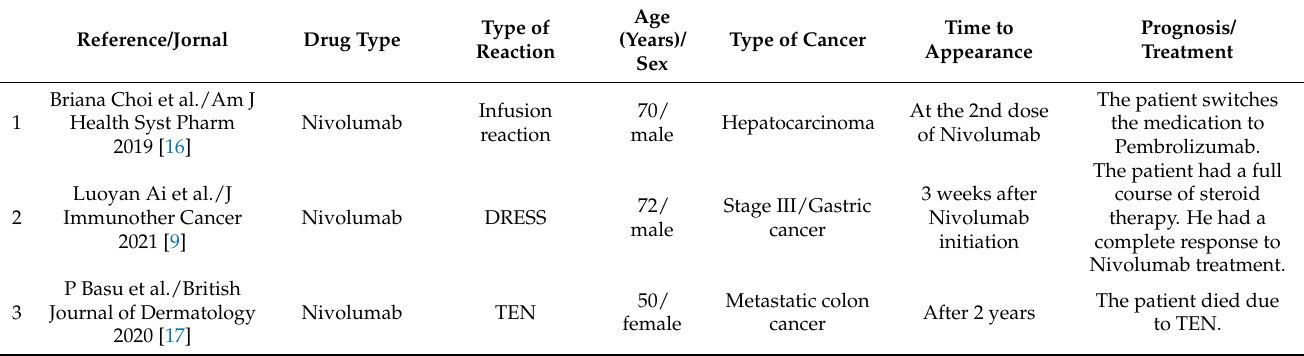
Table 2. Cases of Nivolumab hypersensitivity